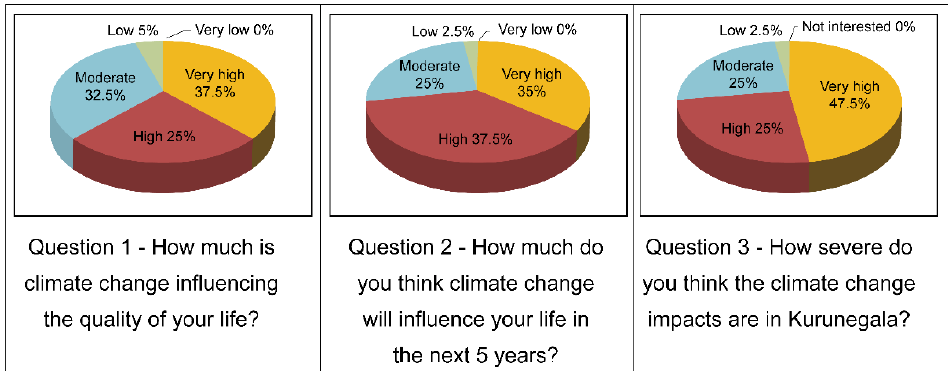
Figure 7. Women’s awareness of local climate change impacts.